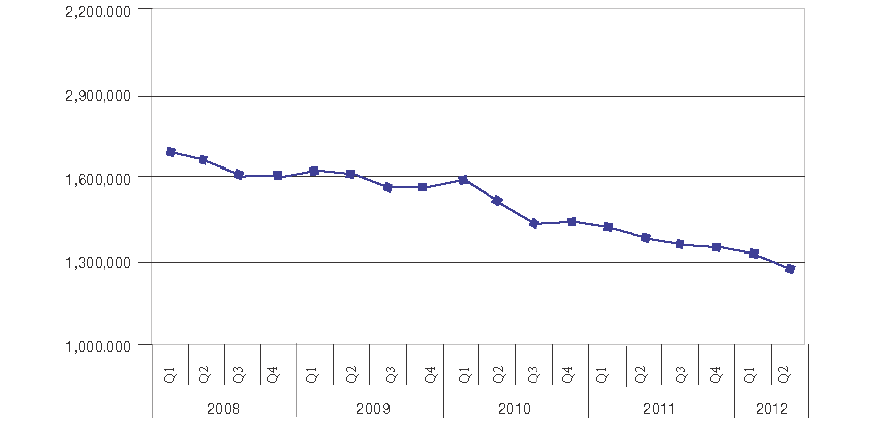
Fig. 1. The four year trend analysis shows a decline of daily newspapers Source: SoN, 2013, p.